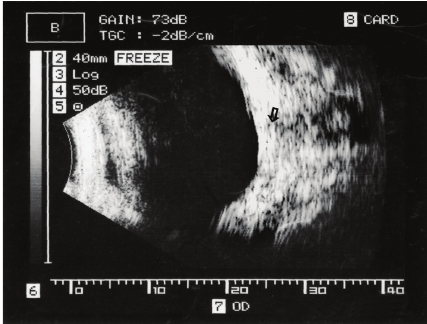
Figure 2: Vertical macula B-scan ultrasonogram demonstrating a calcific subretinal focus (arrow) with acoustic aftershadow of retrobulbar